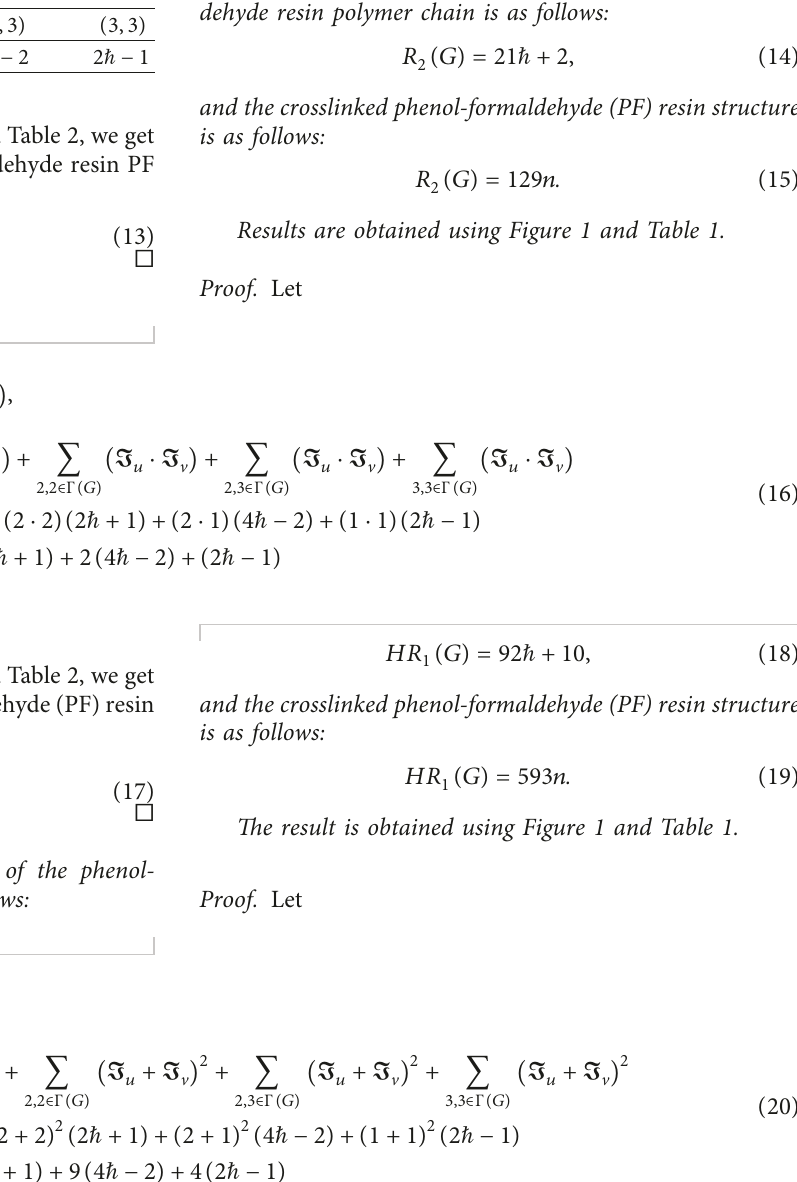
Figure 1: Phenol-formaldehyde (PF) resin polymer chain structure. Table 1: Degree-based edge